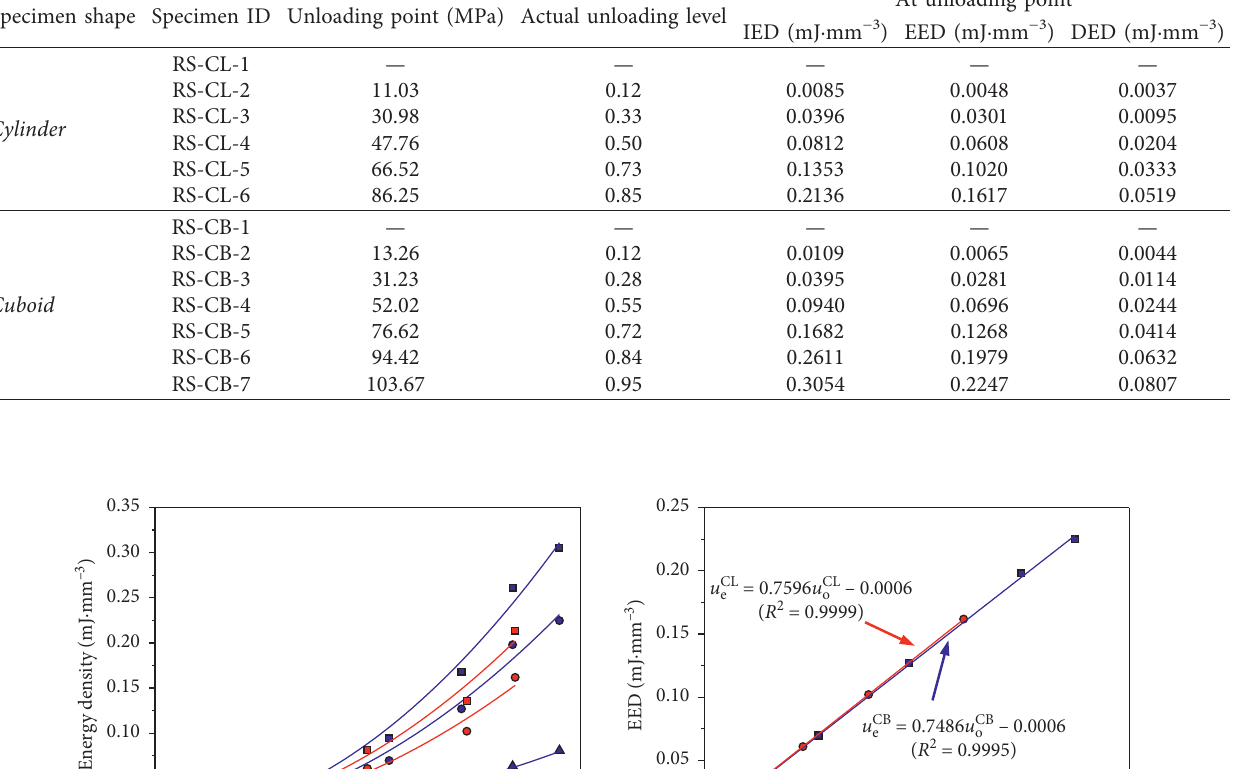
Table 3: Calculation results of energy